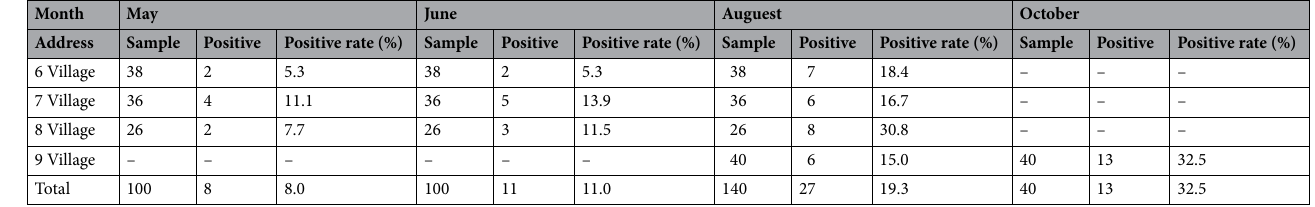
Table 4. Results of neutralizing antibody against WNV in serum of chickens in Kashgar Region, 2013 (PRNT90). Chicken blood was not collected in July and September.